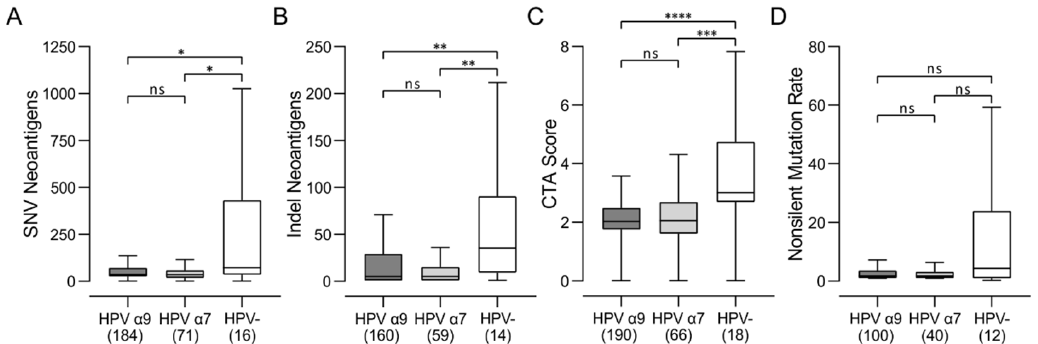
Figure 9. Comparison of the levels of potential neoantigens in HPV-positive (HPV α 9 and HPV α 7) and HPV-negative (HPV-) cervical cancers. Predicted levels of ( A ) single-nucleotide variant (SNV) neoantigens; ( B ) insertion–deletion (indel) neoantigens; ( C ) cancer testis antigen (CTA) score; and ( D ) non-silent mutations. Numbers in brackets refer to the number of samples included in each analysis. **** p ≤ 0.0001, *** p ≤ 0.001, ** p ≤ 0.01, * p ≤ 0.05, ns (not